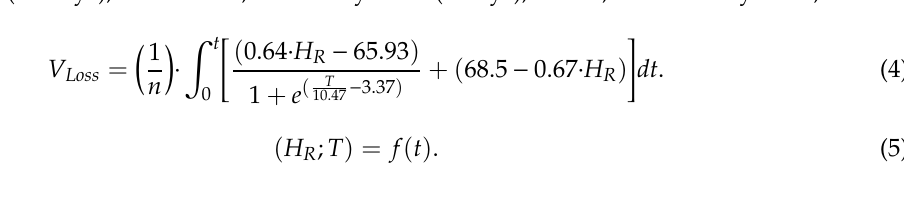
Table S1: Data parameters for the Boltzmann model for volume loss at constant relative